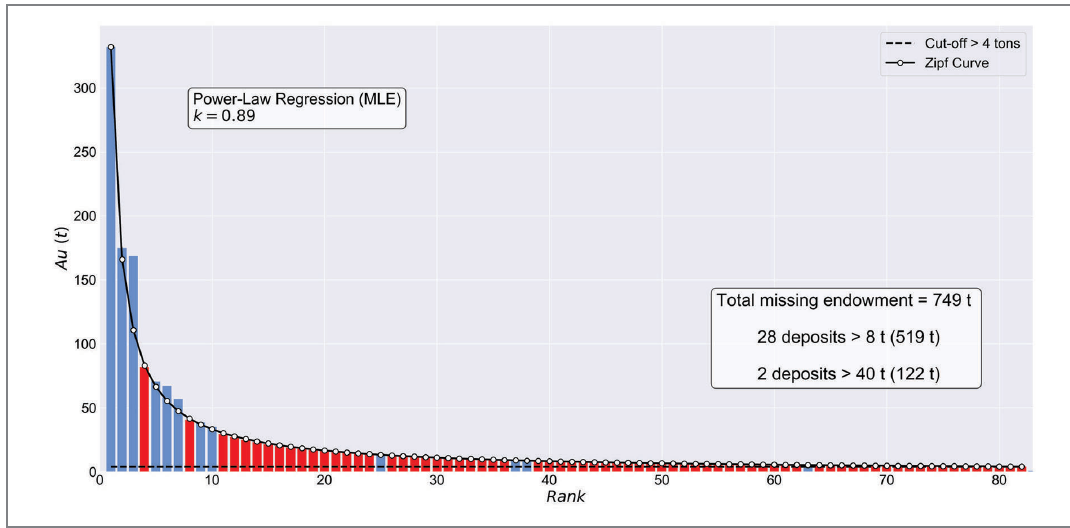
FIGURE 5 - Known gold deposits (blue bars) fitted to the Zipf’s curve, and the rank gaps filled with undiscovered deposits (red bars) with an endowment greater than 4